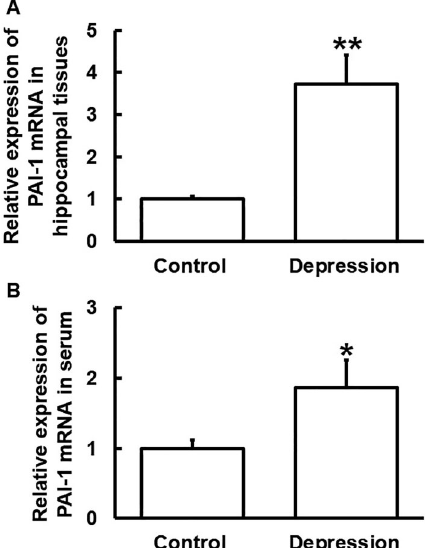
Figure 2. Relative expression of plasminogen activator inhibitor-1 (PAI-1) mRNA in ( A ) hippocampal tissues and ( B ) serum from mice in the control and depression groups. Expression of mRNA was determined by qRT-PCR. Data are reported as means ± SD. *P o 0.05 and **P o 0.01 compared with control ( t -test).